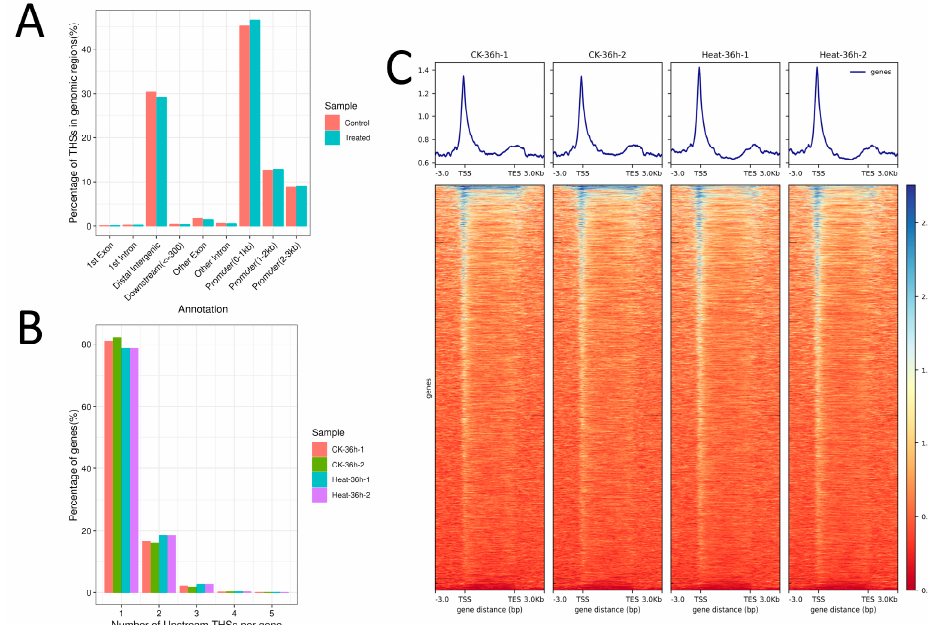
Figure 1 . Distribution of THS in rice under heat stress. ( A ) THS genomic distribution in control and heat stress treatment (36 h). ( B ) The distribution of THSs in the upstream region of each rice gene. ( C ) The average plot and heatmap of ATAC-seq signals for over-enriched THSs in control (CK 36 h-1 and 2) and 36 h heat stress groups (Heat 36 h-1 and 2).